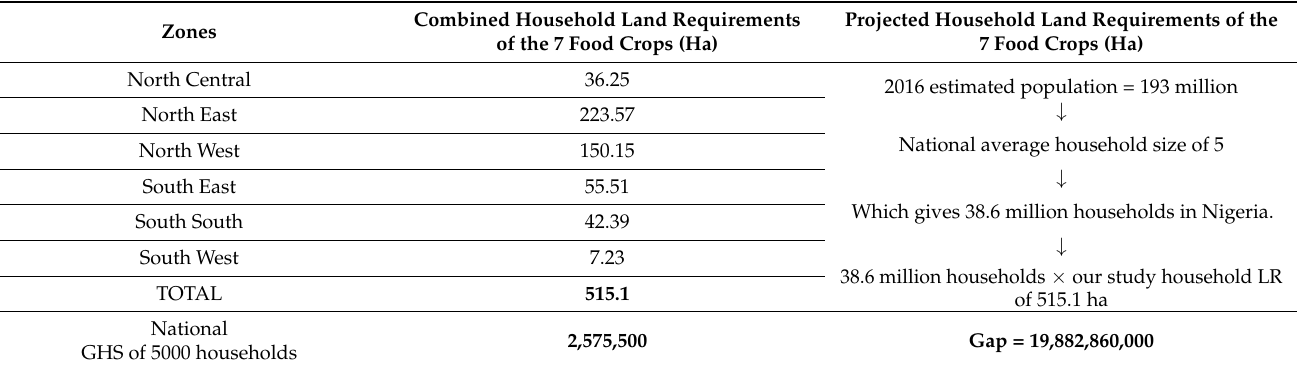
Table 5. Current gap in household land requirements for food in Nigeria and in the six geopoliti- cal zones.